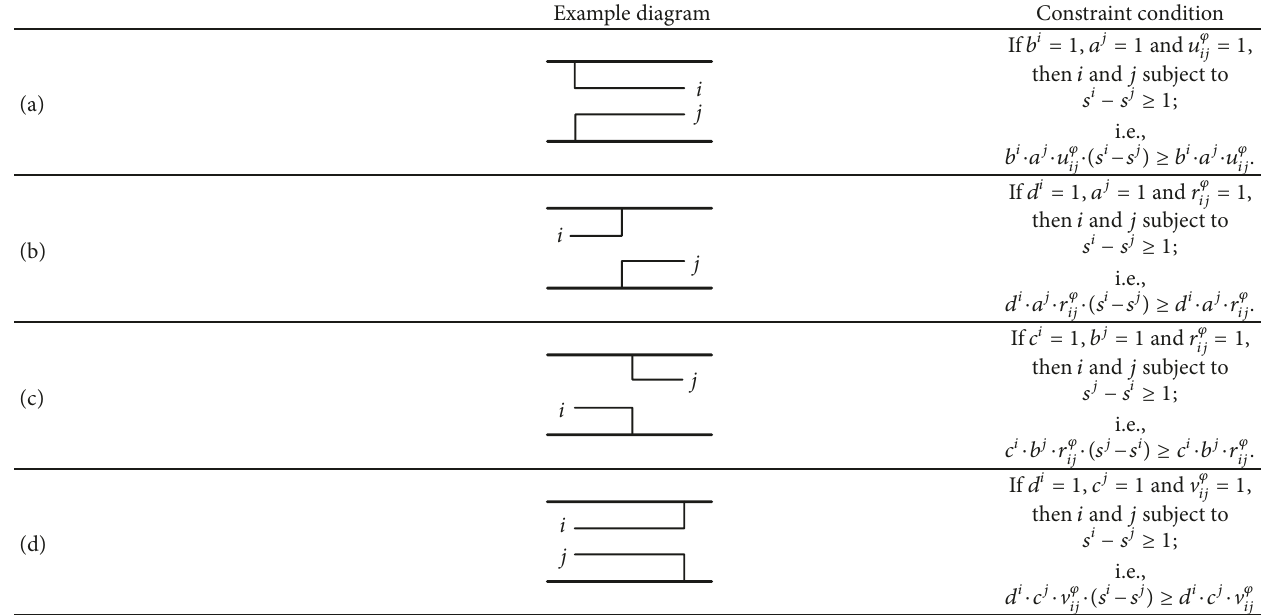
Table 2: Schematic representation of overlapping LL and RL in locomotive working